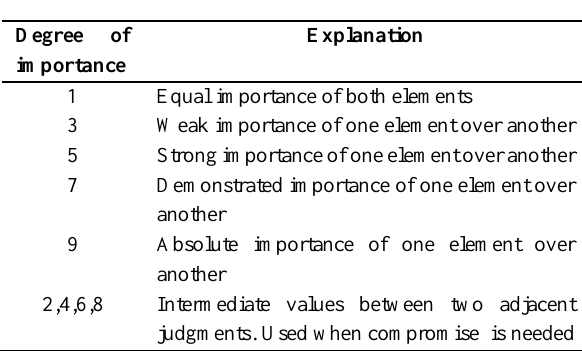
Table 1. Binary comparison